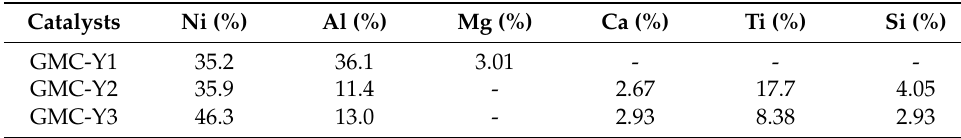
Table A2. Compositions of the GMC-Y1, 2, 3 catalysts.